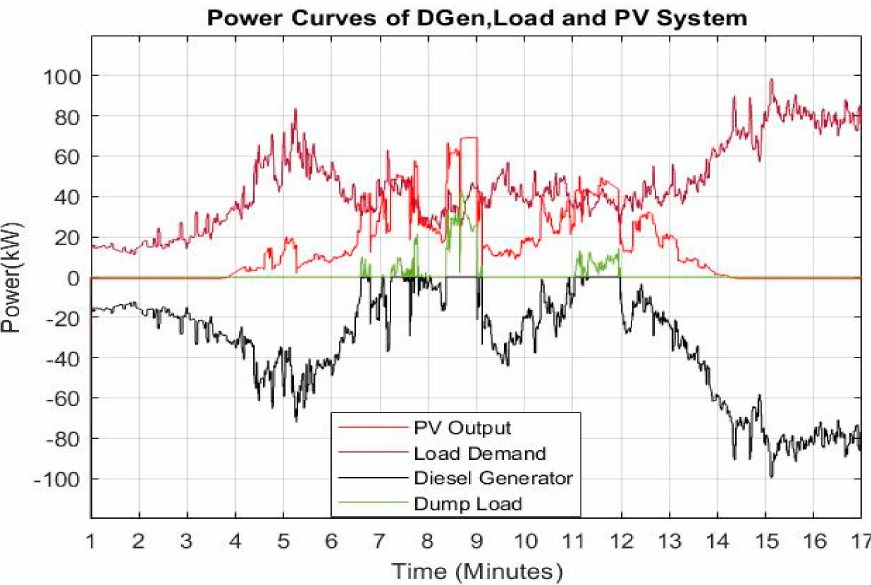
Figure 18. Power curves of PV system, load demand and Dgen for load profile 3. Figures 19 and 20 show the three phase currents and DC link voltage respectively.